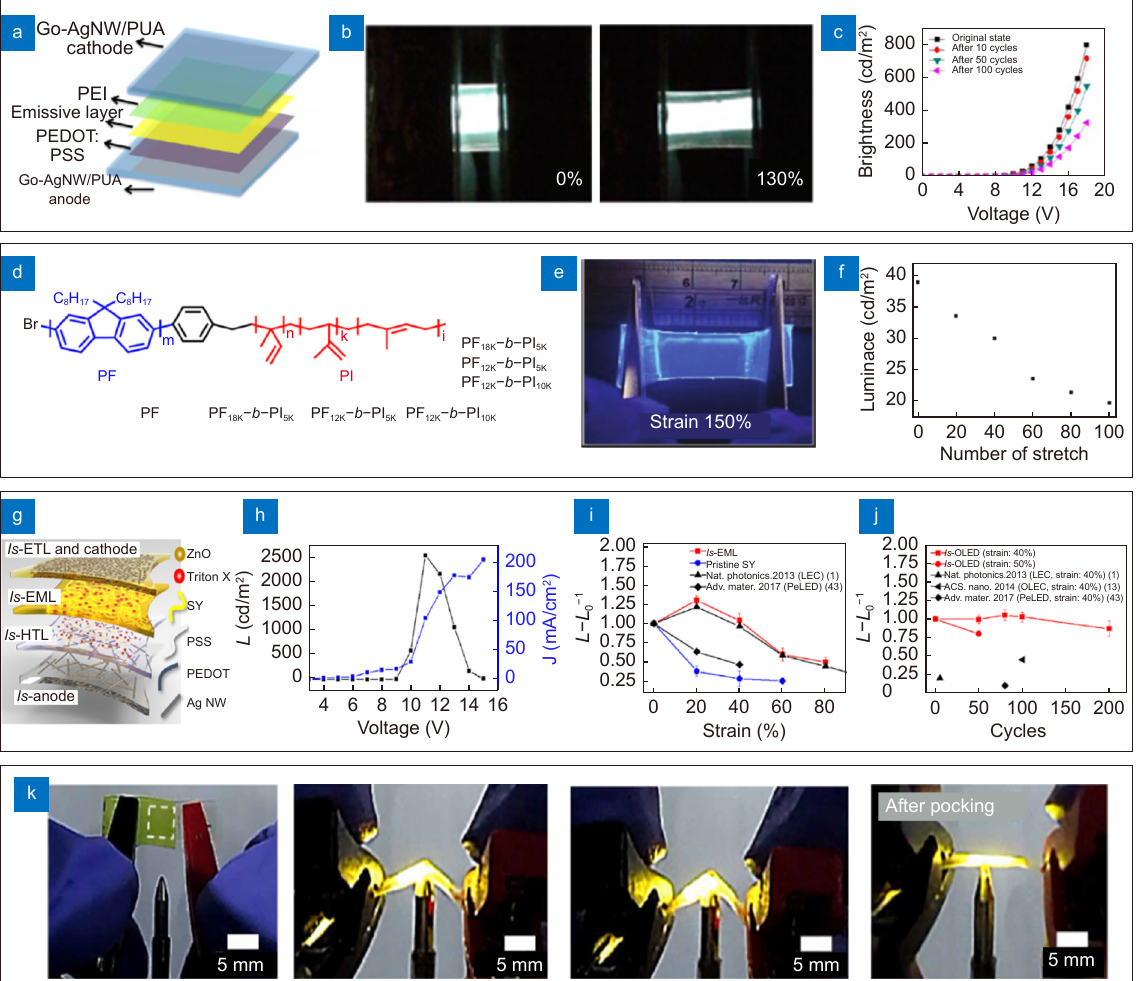
Fig. 9 | LEDs with intrinsic stretchability. ( a ) Structure of the intrinsically stretchable LED based on Go-soldered Ag NW/PUA composite elec- trodes and OXD-7 mixed white-light-emitting layer. ( b ) Photographs of the stretchable LED before and during stretching. ( c ) Stability of the stretchable LED after cyclic stretching tests. ( d ) Chemical structure of a stretchable EML of PF- b -OU copolymer. ( e ) Photograph of the stretch- able LED during stretching with 150% strain. ( f ) Change in luminance of the LED after stretching cycles. ( g ) Structure of the stretchable LED based on small-molecule surfactant added stretchable layers. ( h ) Luminescence and current density of the stretchable LED. Change in lumines- cence with respect to ( j ) increasing strain and (j) stretching cycles. ( k ) Photographs of the stretchable LED working after poking with a ballpoint pen. Figure reproduced from: (a–c) ref. 176 , American Chemical Society; (d–f) ref. 177 , John Wiley and Sons; (g–k) ref. 109 , under a Creative Com- mons Attribution NonCommercial License